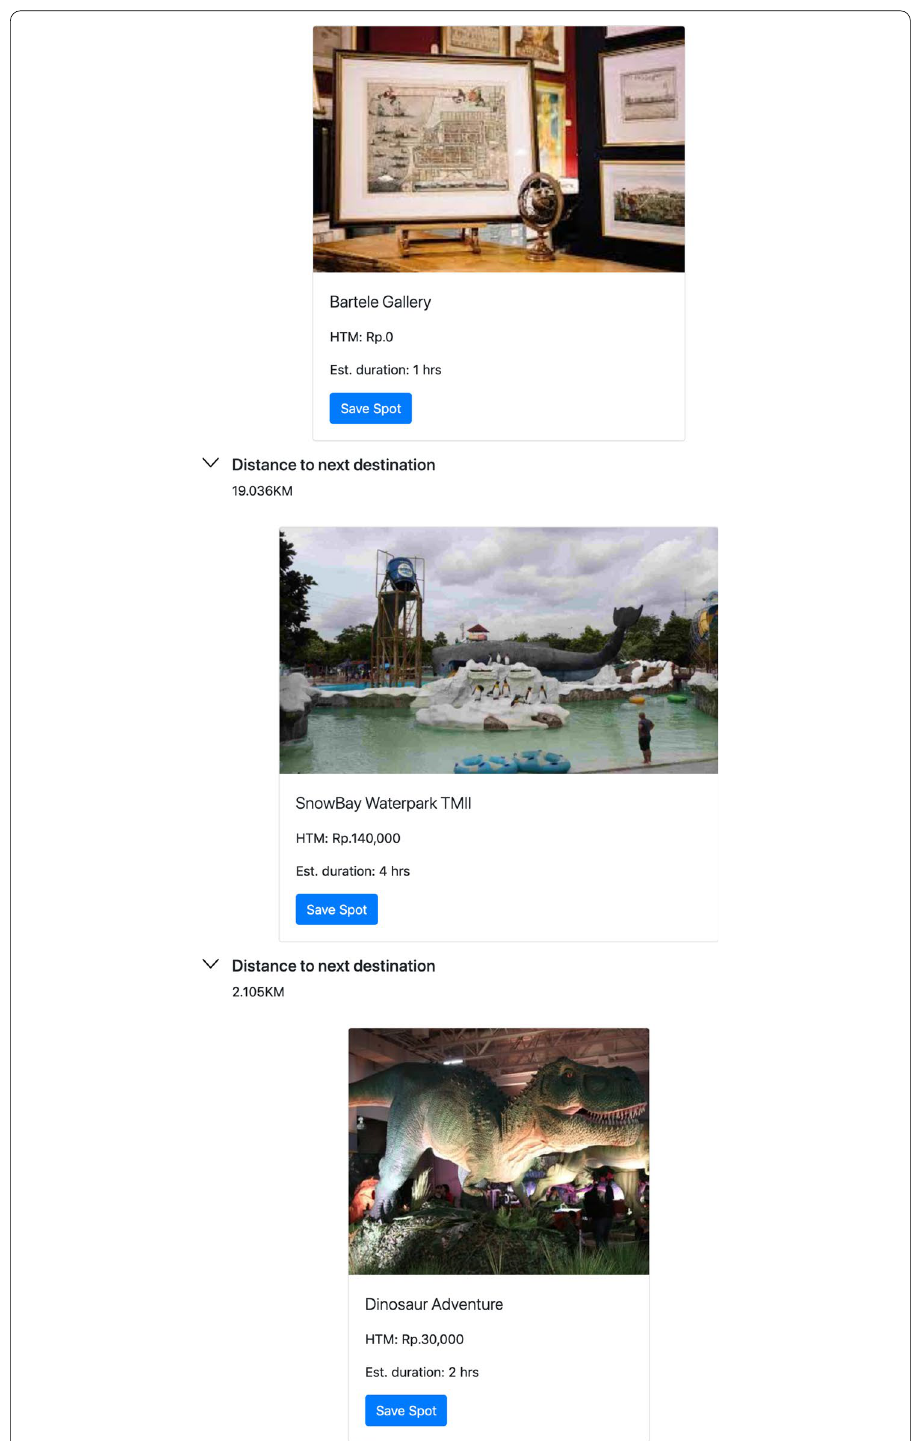
Fig. 6 UI design for list of trip recommendation